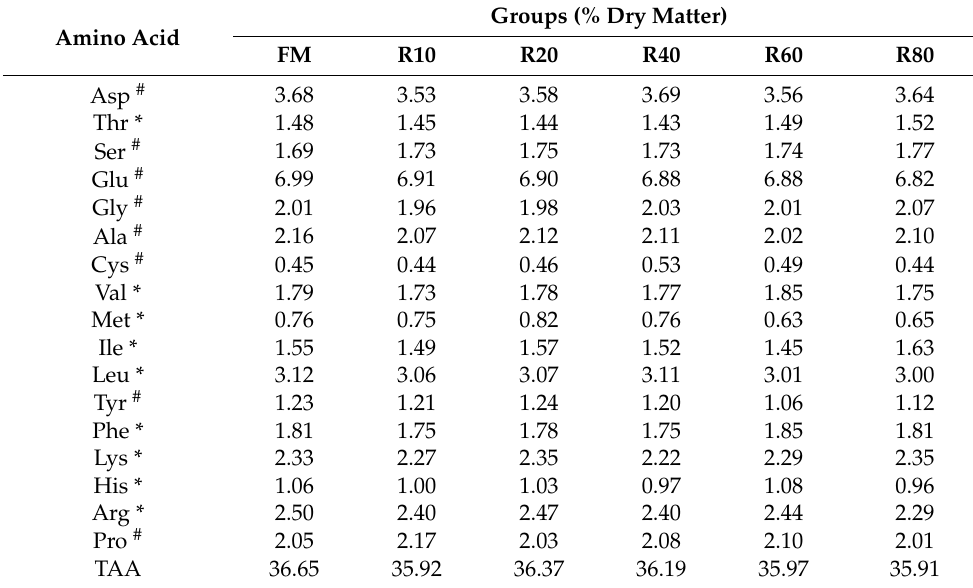
Table 2. Amino acid composition of